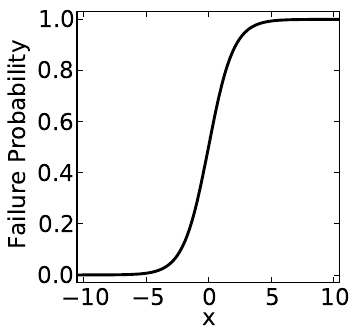
Fig. 3. Logistic sigmoid function defined in Eq. (3) with λ(x) = x .